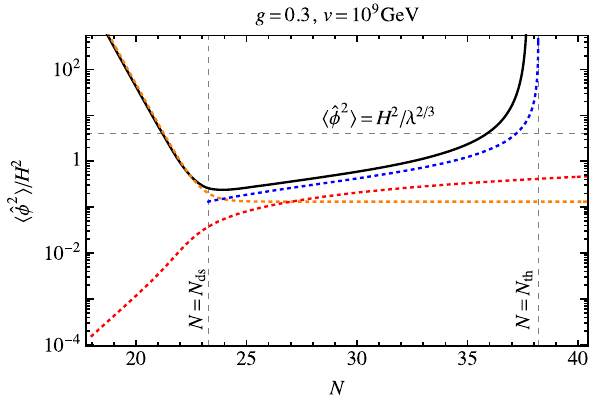
Fig. 3 Evolution of the variance of the fluctuations of the scalar field as a function of e -folds of inflation. The solid black curve shows the numericalresult,theredandorange dashedcurves thevacuum andther- mal contributions obtained from the BD solution, and the blue dashed curve the tangent approximation (19). The vertical dashed lines indicate the moment when the symmetric phase becomes unstable, N = N ds , and the end of thermal inflation, N = N th . The horizontal dashed line marks the transition to the classical